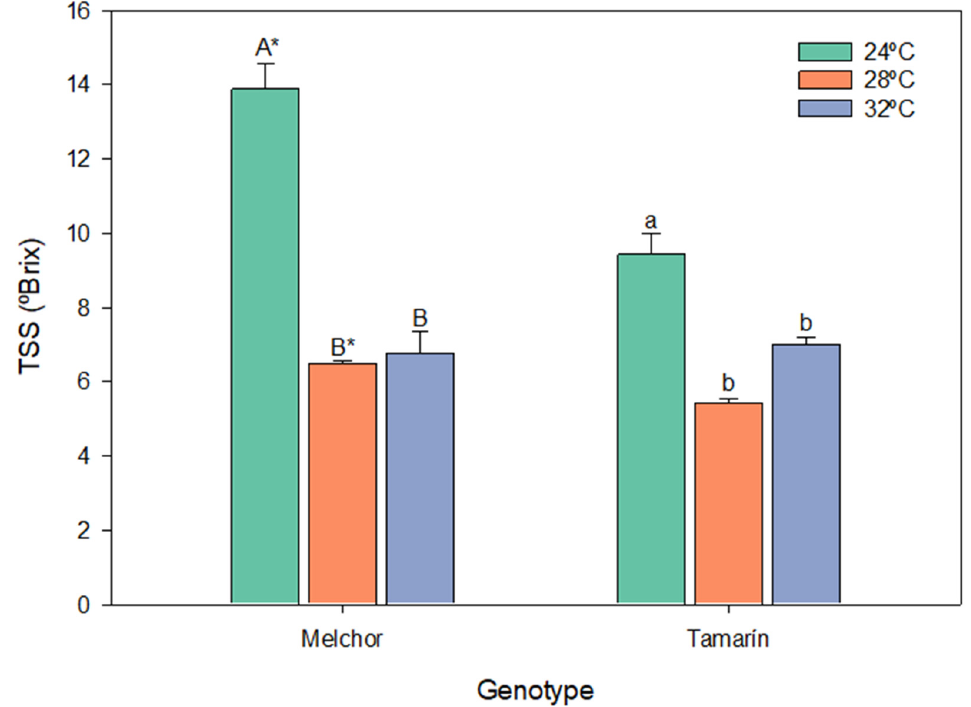
Figure 3. Effect of temperature (24 °C, 28 °C, and 32 °C) on total soluble solids (TSS) of Melchor and Tamarín fruits. The data are presented as the treatment means ( n = 6) ± S.E. Different lowercase letters indicate significant differences between temperatures in Melchor and different uppercase letters indicate significant differences between temperatures in Tamarín. * Denotes significant differences between two cultivars grown under the same temperature conditions.